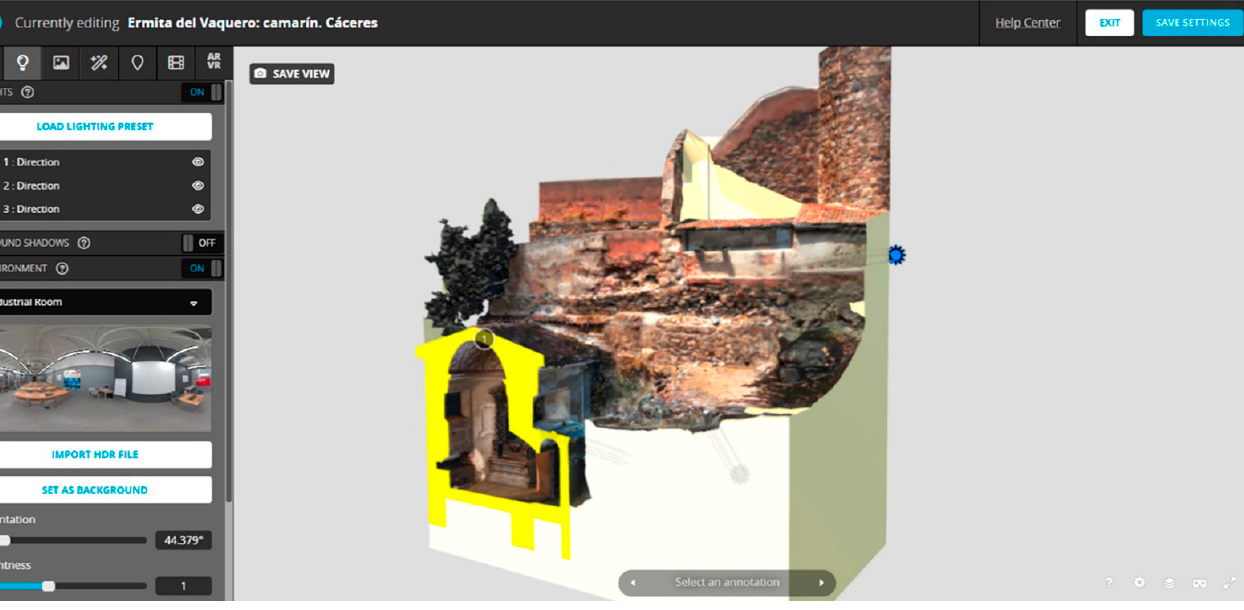
Figure 16. Different customizations in PBR of the preconfigured materials in activity I. Customiza- tion of the clipping region in orange and red and, finally, replacement of all texture maps by a solid red color. In this way, if the exported model is ordered in pieces in activity I, we have the free- dom to edit the materials of each piece independently. Each piece can be textured as if we were using a typical 3D program (3D Studio, Rhinoceros, AutoCAD, Maya, etc.) with complex materials and textures or solid colors. Among the modifiers that we can use depending on our needs, we can highlight the following: anisotropy—add reflections over a patterned surface; roughness or glossi- ness—select how surface irregularities affect the reflection of light; displacement—add a